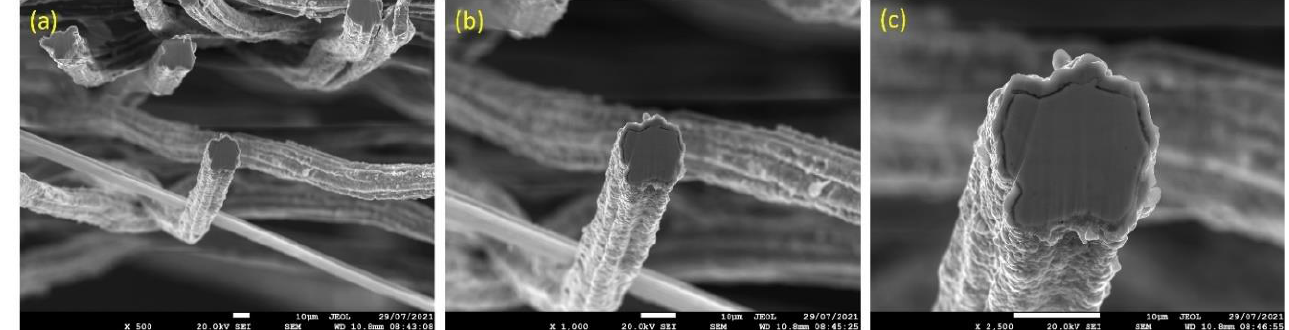
Figure 6. SEM micrographs of cross section of 12 μm FeCrAl fibers, after one MSHT cycle, at different magnifications: ( a ) ×500, ( b ) ×1000, and ( c ) ×2500.